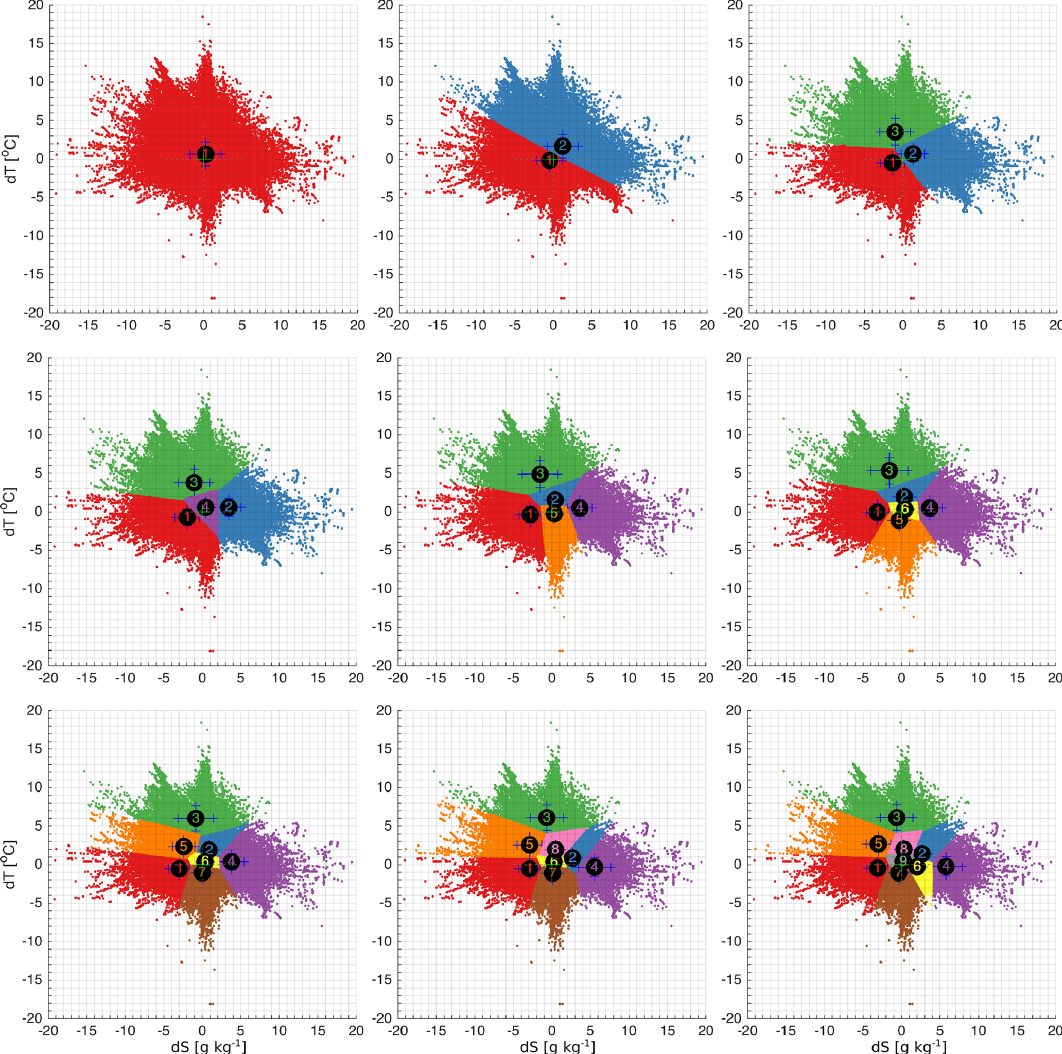
Figure A1. The distribution of clusters in the error space for a different number of predefined clusters, K = 1–9. The numbers of the clusters correspond to the numbers of the clusters in Table 1. The locations of the centroids are marked with cluster numbers and the standard deviations with the